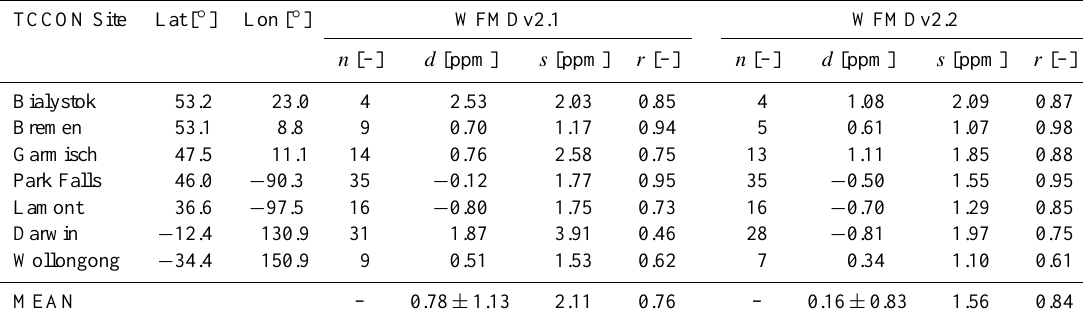
Table 3. Results of the comparison of WFMDv2.1 and v2.2 X CO 2 data with ground based FTS measurements at various TCCON sites. The comparison is based on monthly data. Shown are the number of months used for the comparison ( n ), the mean difference to FTS ( d ), the standard deviation of the difference ( s ) and the correlation ( r ). In addition, the following quantities are given in the bottom row (MEAN): the averaged mean difference (global offset), the standard deviation of the mean differences (relative regional-scale accuracy), the mean standard deviation of the differences (monthly regional-scale precision) and the mean